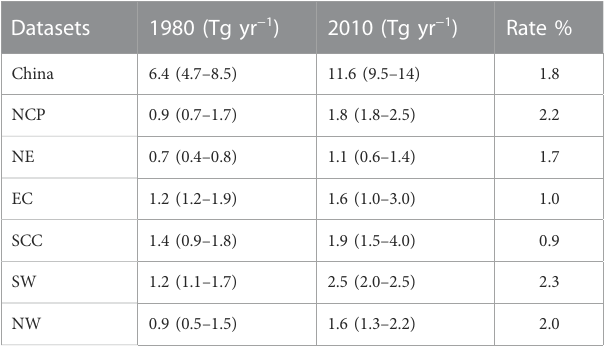
TABLE 2 The average annual growth of NH 3 emission in six different regions from 1980 to 2010. (Detailed information of regions is in Supplementary Table S2.)